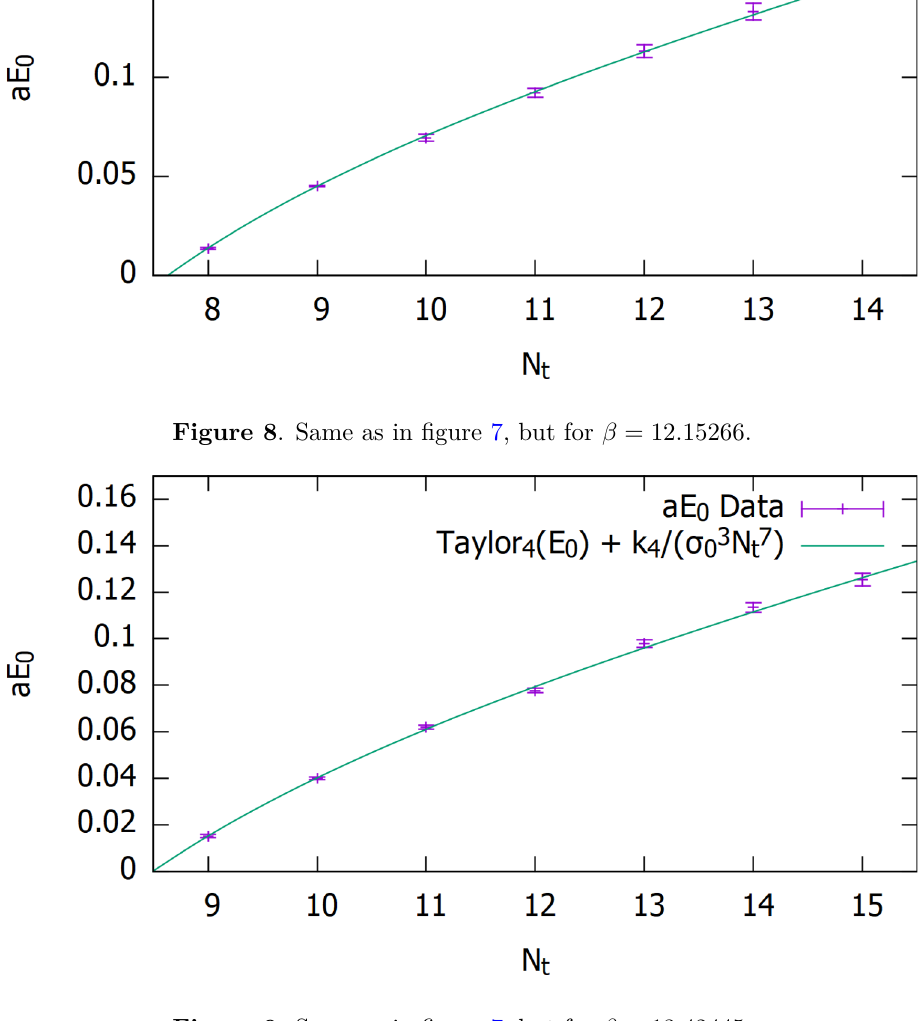
Figure 9 . Same as in figure 7, but for β = 13 . 42445